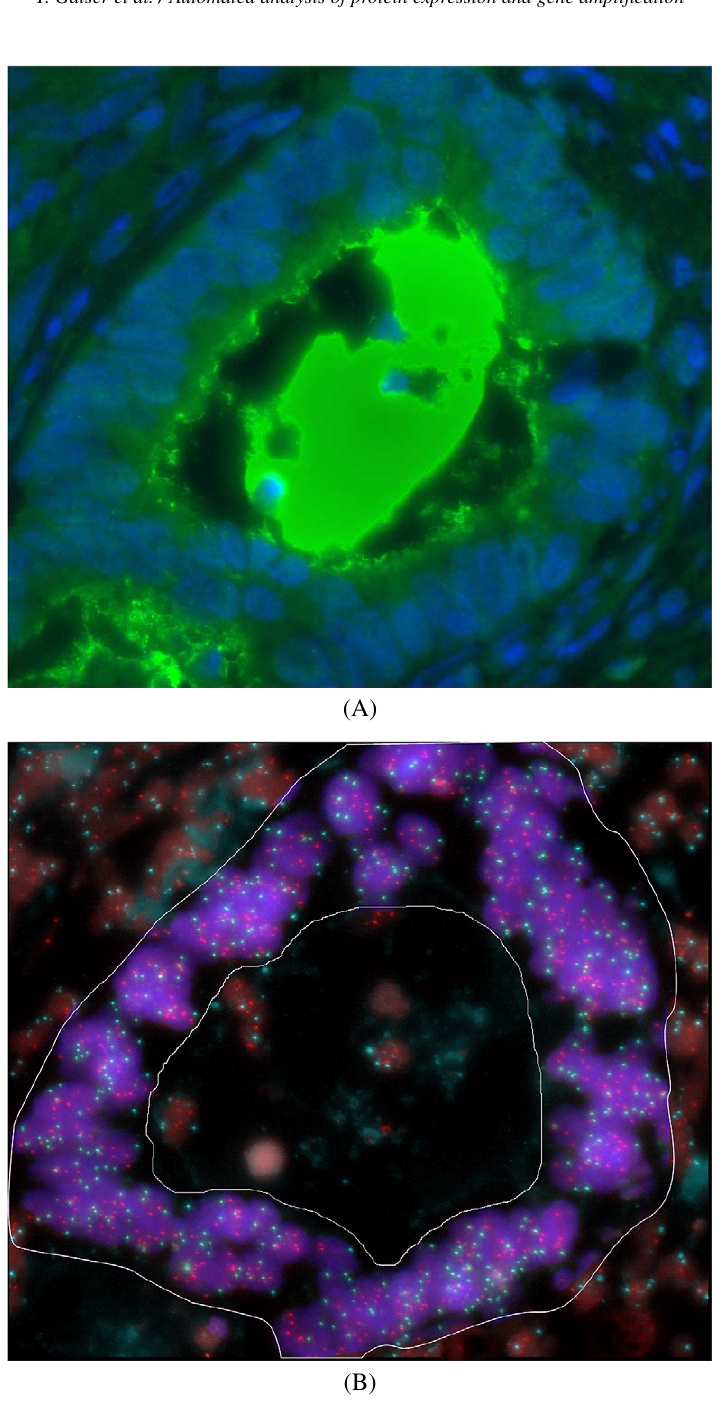
Fig. 2. IHC and FISH image of the same tumour gland. (A) Immunofluorescence of a CD133 positive tumour gland. The CD133 protein expres- sion is localized to the glandular–luminal surface and intraluminal of the tumour. (B) FISH for ZNF217 (Spectrum Orange) and centromere 6 (Spectrum Aqua) in the same gland as shown in A. Only the tumour gland (the area within the demarcation) was selected for evaluation, the nor- mal surrounding cells as well as apoptotic cells in the lumen were excluded. This case was amplified for ZNF217 showing a ratio ( ZNF217 /CEP6) of